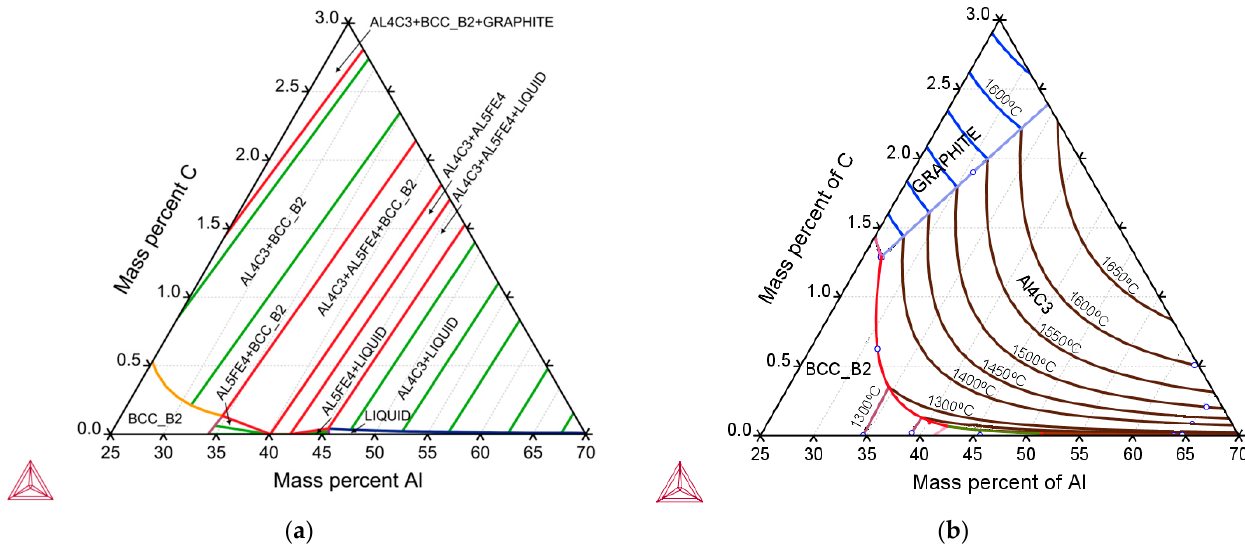
Figure 2. Fe–Al–C equilibrium phase diagram alloys obtained in the Thermo-Calc program at a temperature of 1400 °C ( a ) and determination of the liquidus temperature ( b ).